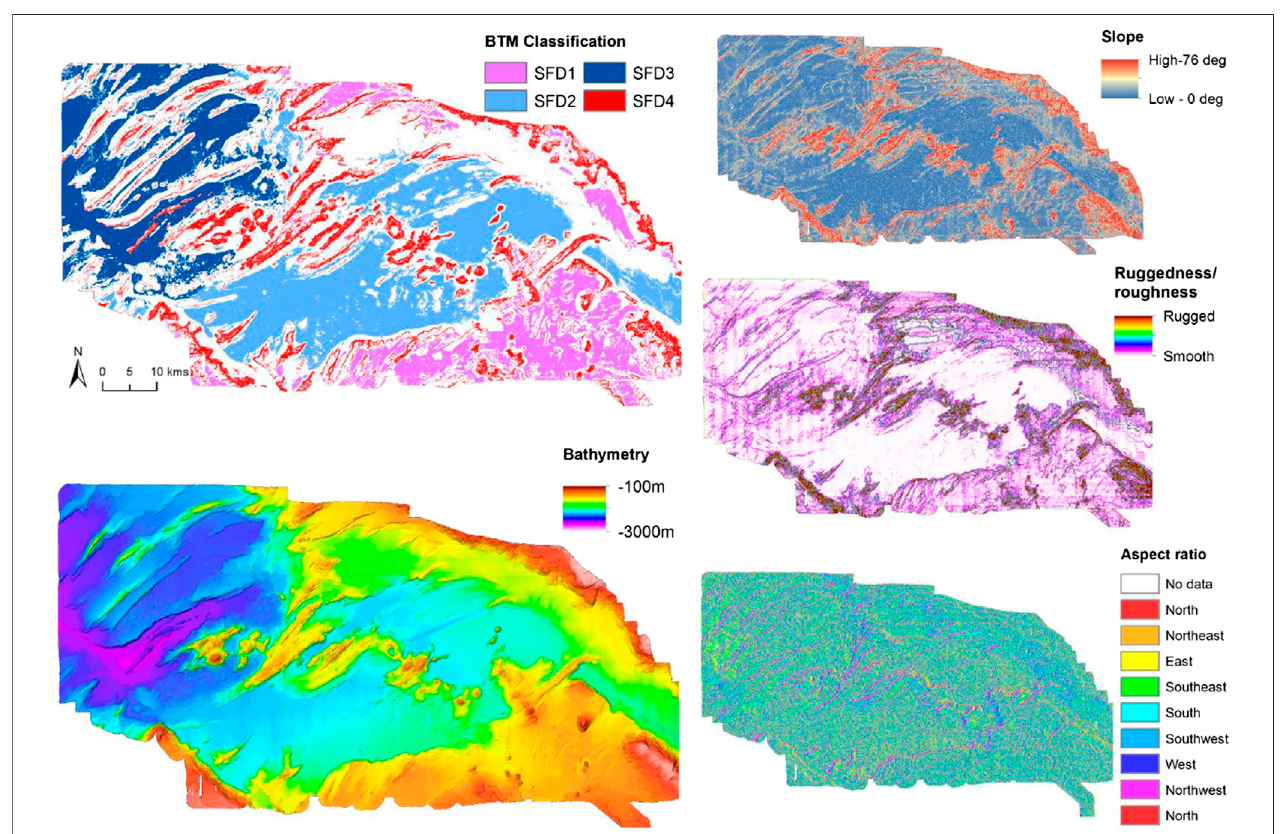
FIGURE 5 | Raster models generated from BTM classi fi cation. Pixel-based (neighborhood comparison) output from bathymetric terrain modeler. Four separate sea fl oor domains are identi fi ed in this classi fi cation. Included in the inset fi gures are bathymetric derivatives (slope, ruggedness and aspect ratio).